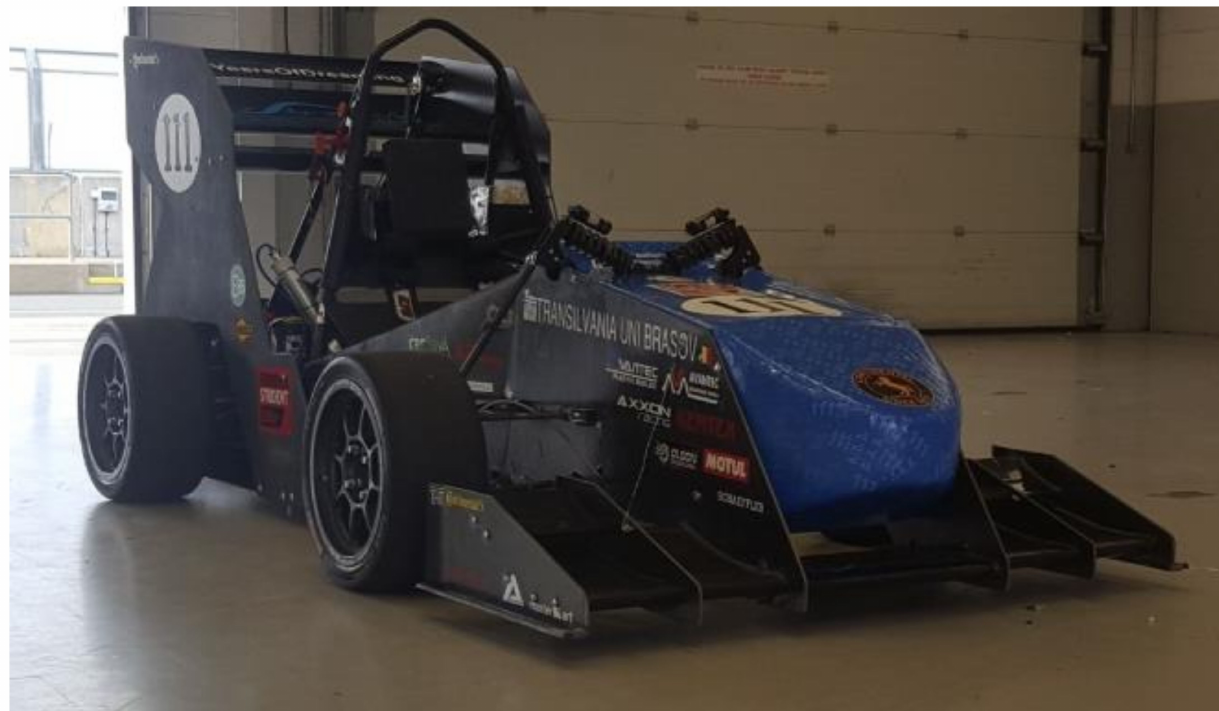
Figure 3. BlueStreamline